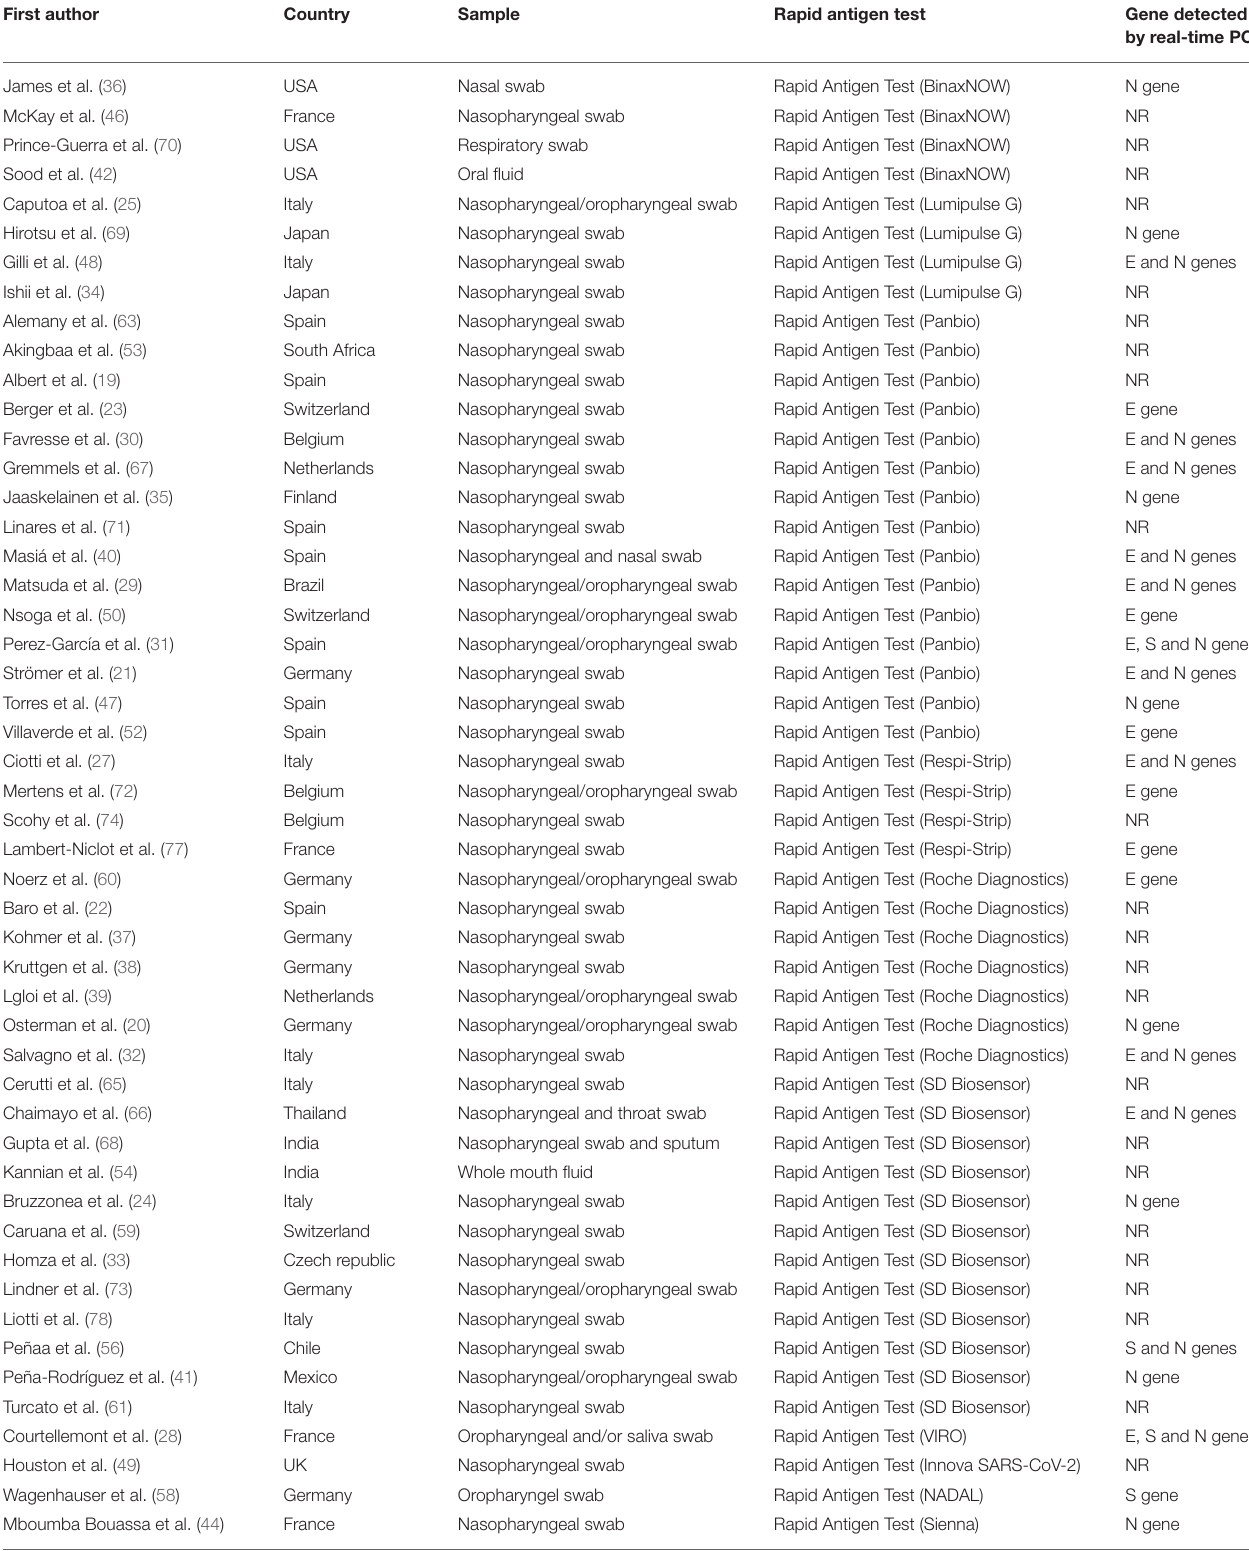
TABLE 1 | Characterization of included